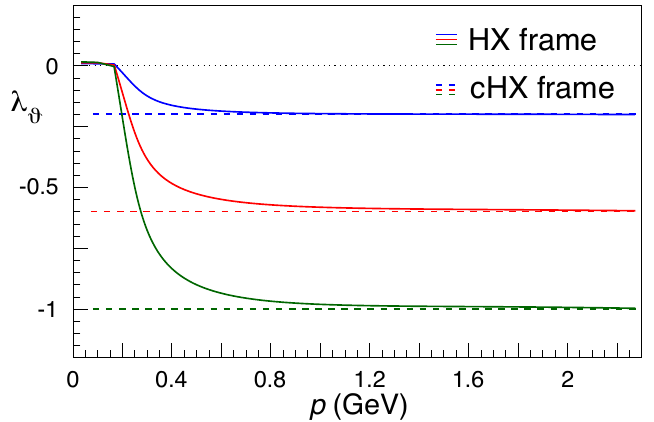
Figure 11 . Polarization smearing from the cHX frame to the HX frame, in the B → J /ψ X decay, for three different natural polarizations: λ cHX ≡ λ 0 = − 1 (green), − 0 . 6 (red), and − 0 . 2 ϑ